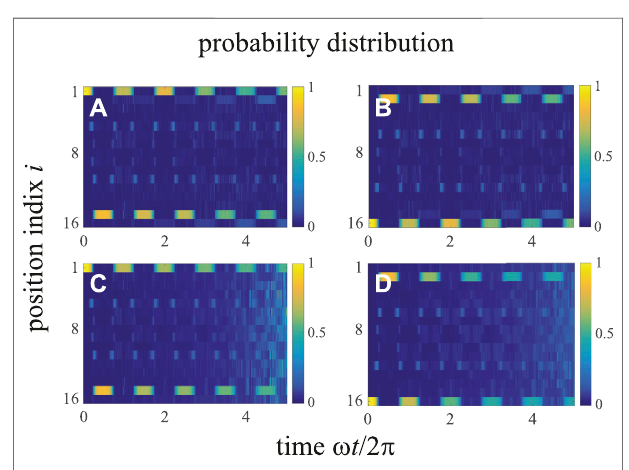
FIGURE 11 | (Color online) Time evolution of the probability distribution for an open chain of N (cid:1) 8. The time dependent pump sequence is de fi ned in Eq.(30)with ω / A (cid:1) 2 π /600, (A,C) P 1 (0) (cid:1) 1; (B,D) P 16 (0) (cid:1) 1. (A,B) areplotted withoutdisorder; (C,D) areplottedforthenormallydistributeddisorder ϵ withastandarddeviation0.01 A .Theotherparametersare J / A (cid:1) 0.1and ϕ (cid:1) 0.